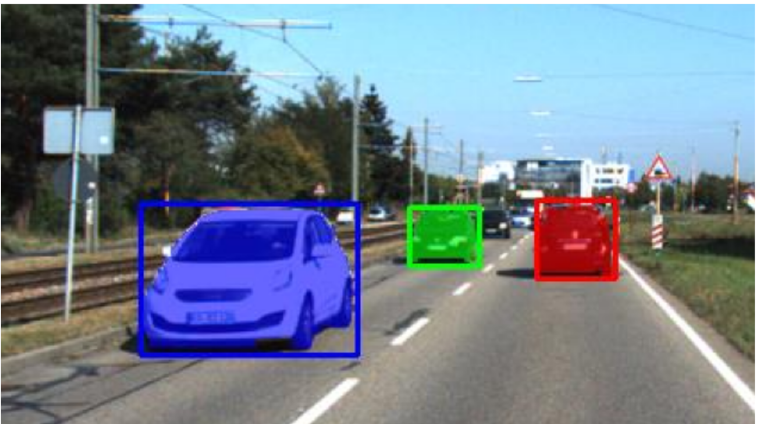
Figure 1. An illustration of bounding boxes including objects/background points. Three bounding boxes are detected, each of which contains background points and an object. The object regions are accurately segmented by blue, red, and green masks generated by our region-level segmentation. The pixels within the masks are used as feature points for tracking and parameter